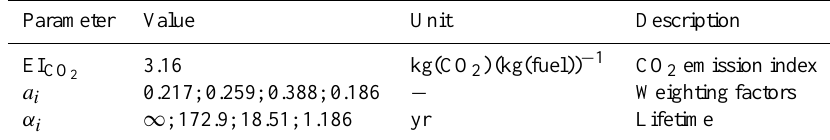
Table 5. Parameters of the CO 2 parameterisation.